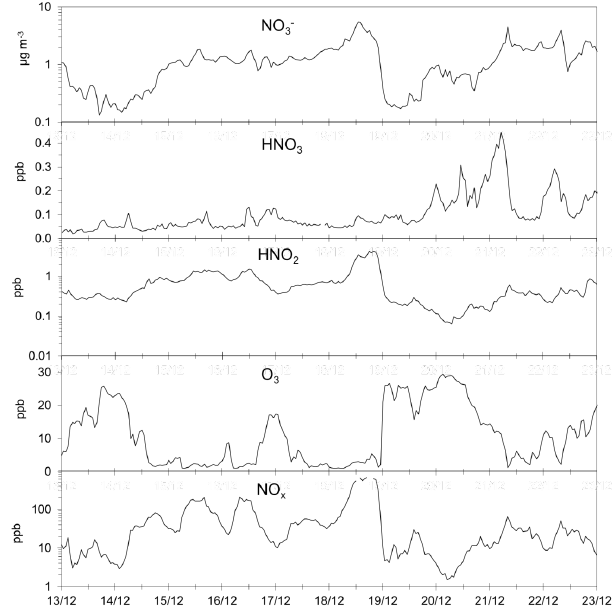
Fig. 7. Ozone, NO x , and the nitrogen-containing gas-phase acids and nitrate in PM 10 in the dark time of the